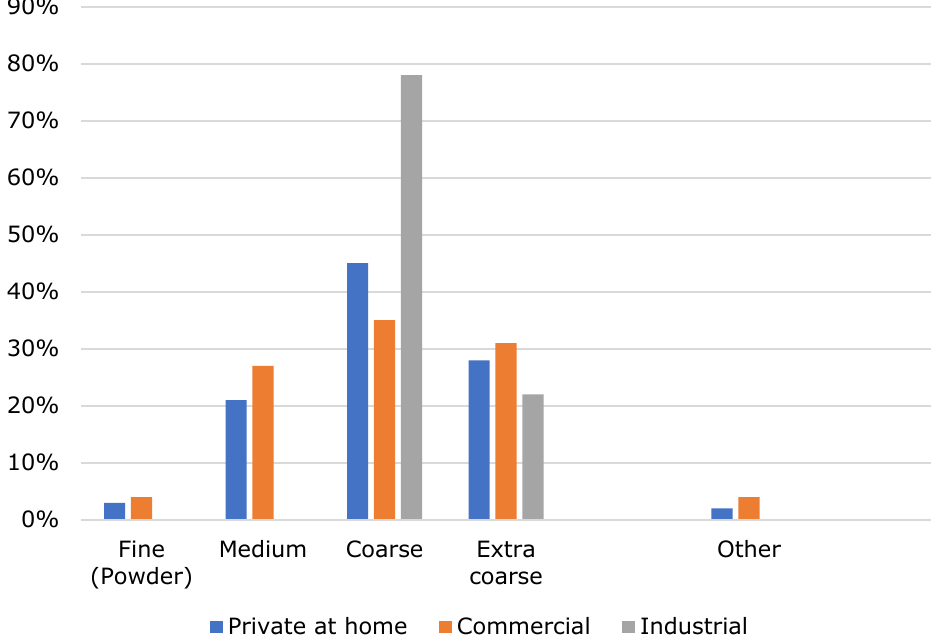
Figure 4. Grinding degree of cold brew coffee. Most of the respondents (53%) use Arabica beans for making cold brew coffee. Only a few (1.7%) use Canephora, Liberica or a blend of several species (3%). However, there are also some participants (41%) who do not know what kind of variety they use.